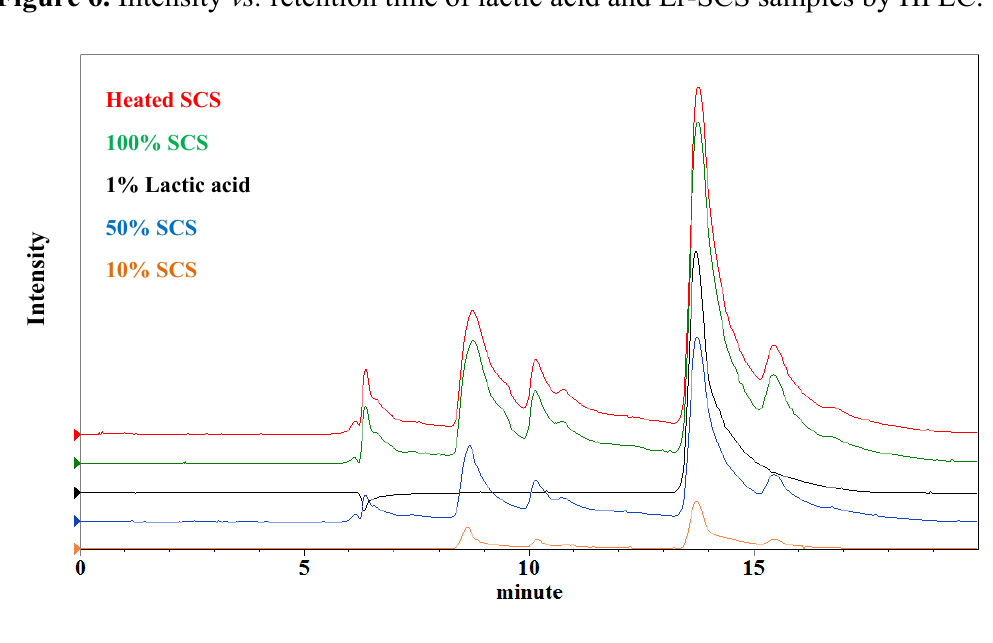
Figure 6. Intensity vs. retention time of lactic acid and Lr-SCS samples by